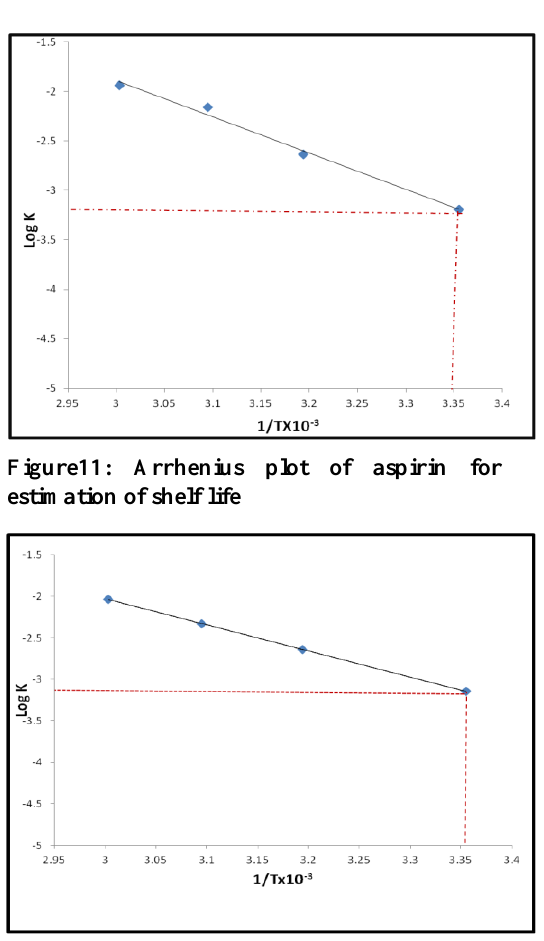
Figure12: Arrhenius plot of clopidogrel for estimation of shelf